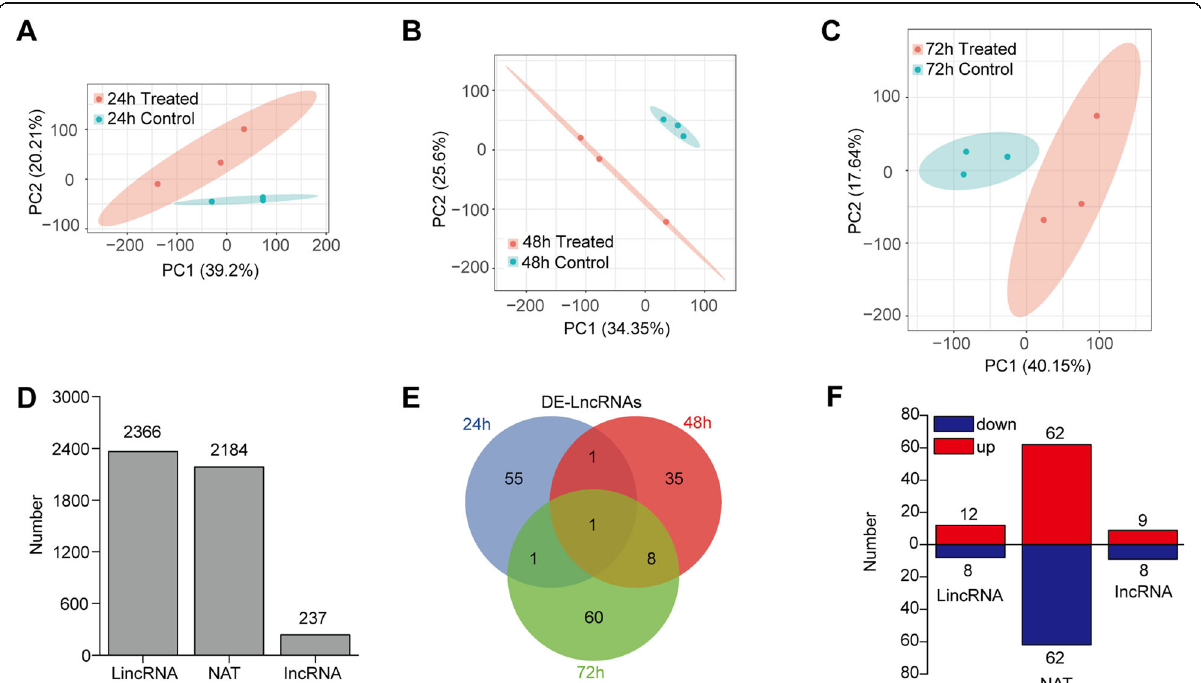
Fig. 1 Overview of blast fungus-responsive LncRNAs in rice. a - c Principal Components analysis (PCA) of mRNA-sequencing data among different treatments. Control, mock treatment. Treated, M. oryzae treatment. d Total numbers of identified LncRNAs in rice. LincRNA, long intergenic non- coding RNA. NAT, nature antisense transcripts. IncRNA, intronic RNA. e A venn diagram showing differentially expressed (DE) LncRNAs 24 h, 48 h and 72 h after M. oryzae treatment. Foldchange > 2, p value < 0.05. f Numbers of up- or down-regulated LncRNAs after blast fungus